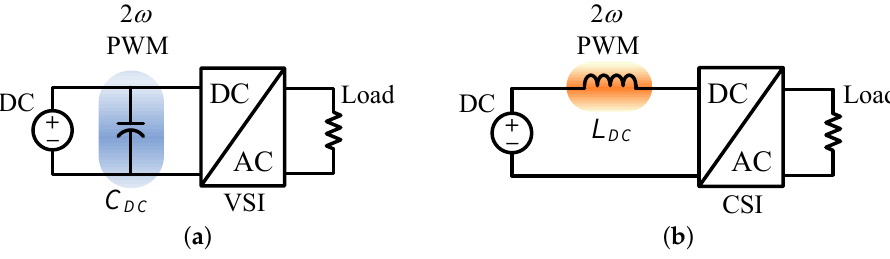
Figure 1. ( a ) Typical voltage-source inverter block diagram and ( b ) current–source inverter block diagram indicating input energy storage elements which reduce 2 ω and PWM